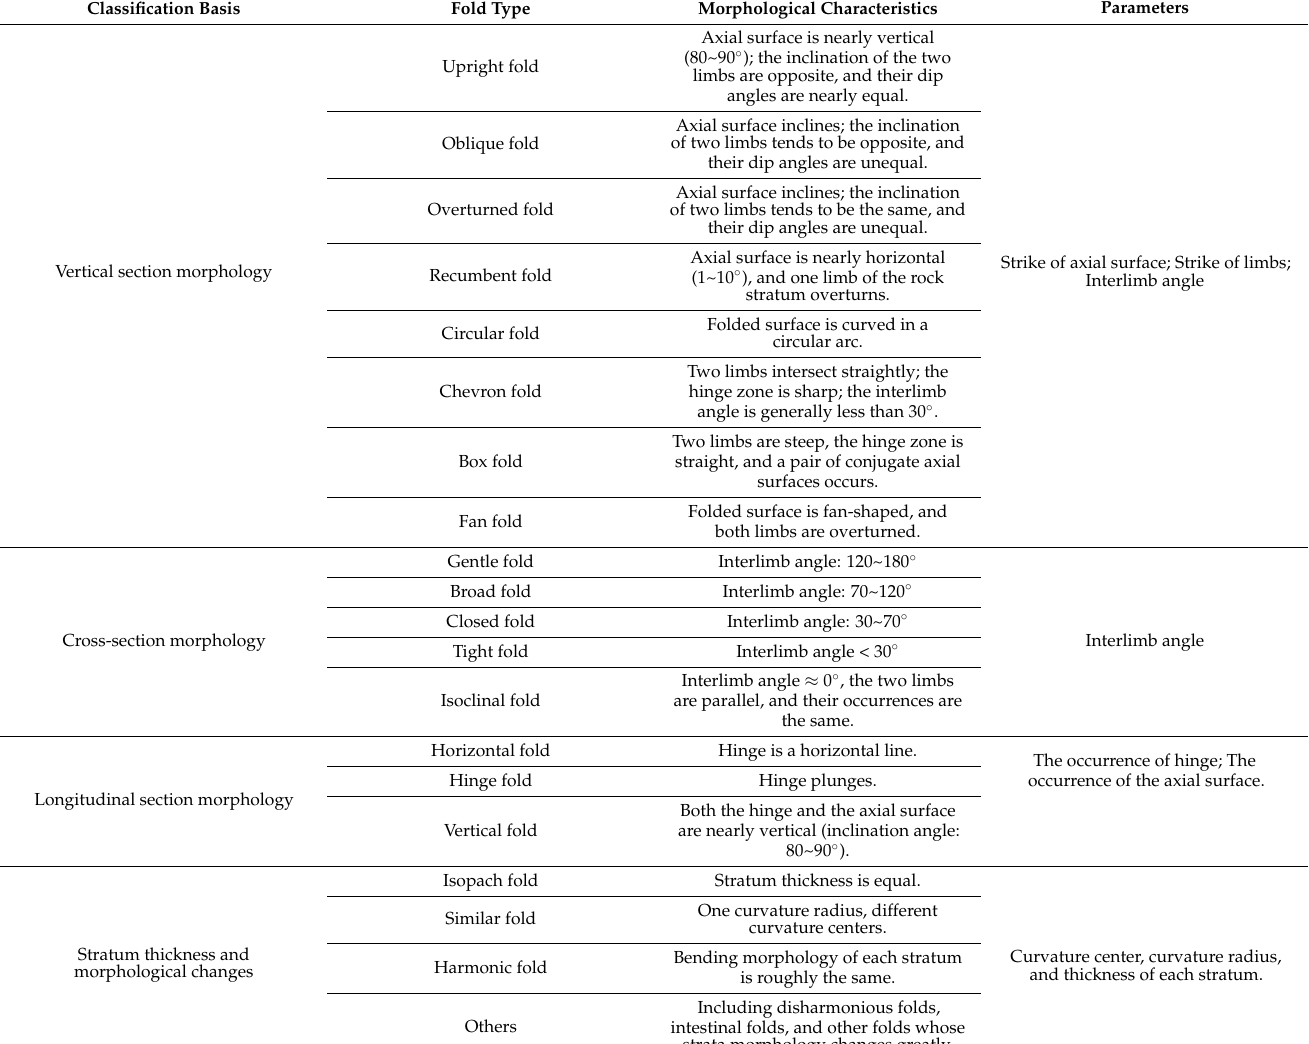
Table 1. Main fold types and their characteristic parameters [41].